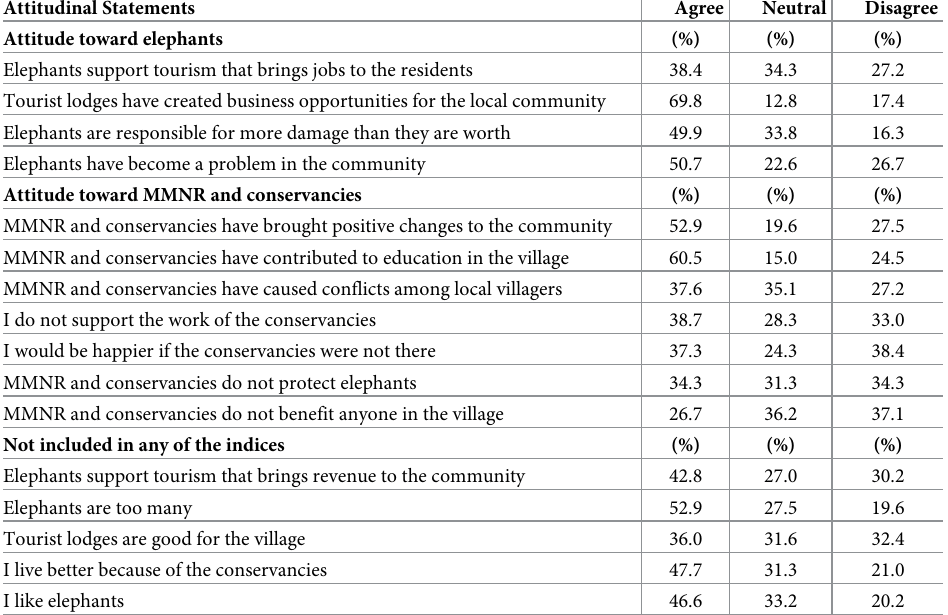
Table 4. Responses to attitudinal